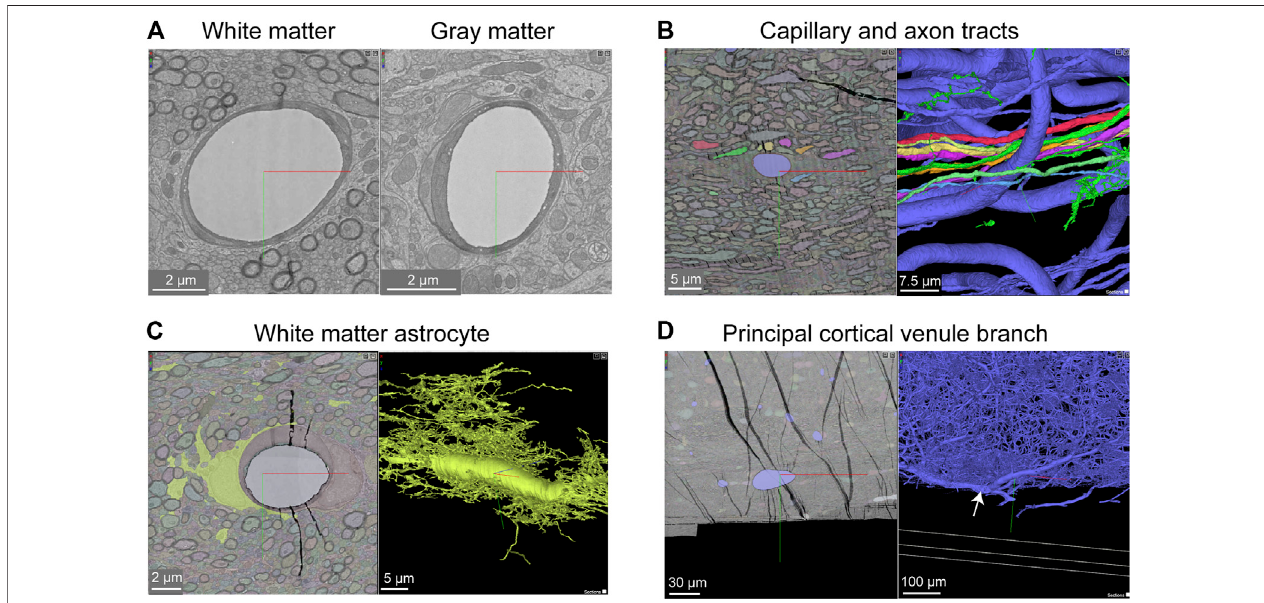
FIGURE10| WhitemattervesselsinMICrONSCorticalMM ^ 3data. (A) Representativecrosssectionofcapillary-sizedvesselsinwhitematter(left)andgraymatter (right). White matter capillary cross-section x, y, z coordinates at: 114029, 277354, 17647. Gray matter vessel cross-section x, y, z coordinates at: 109231, 208260, 17714. (B) A whitematter capillary embedded withinthe axon tracts ofthe whitematter (left). In 3D view, thevascularlumen segmentation isdisplayed, alongsideselect axonsthathavebeensegmented.Coordinatesat:155004,269113,21080. (C) Aperivascularwhitematterastrocyte.In3Dview,thecoverageofthecapillarywall can be seen. Coordinates at: 150176, 279591, 18383. (D) A branch of a deep draining venule, principal cortical venule, is present within the data set. Coordinates at: 195156, 273647,